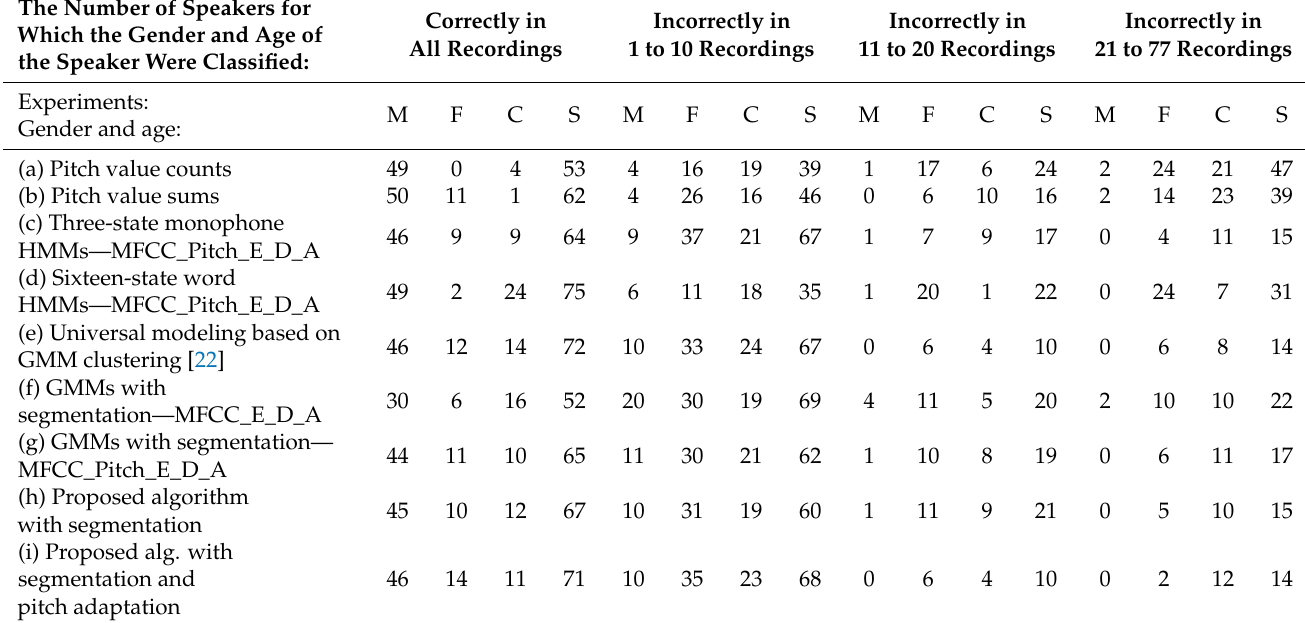
Table 4. Gender and age classification analysis (M—male, F—female, C—child, S—sum of all gender and age classifications) for all 163 speakers.